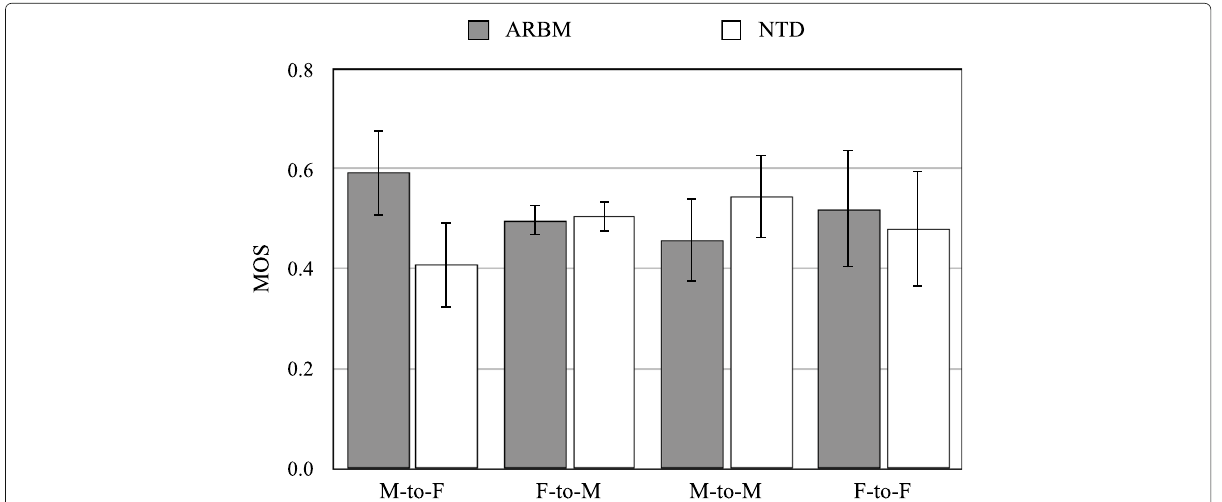
Fig. 8 XAB test between ARBM and